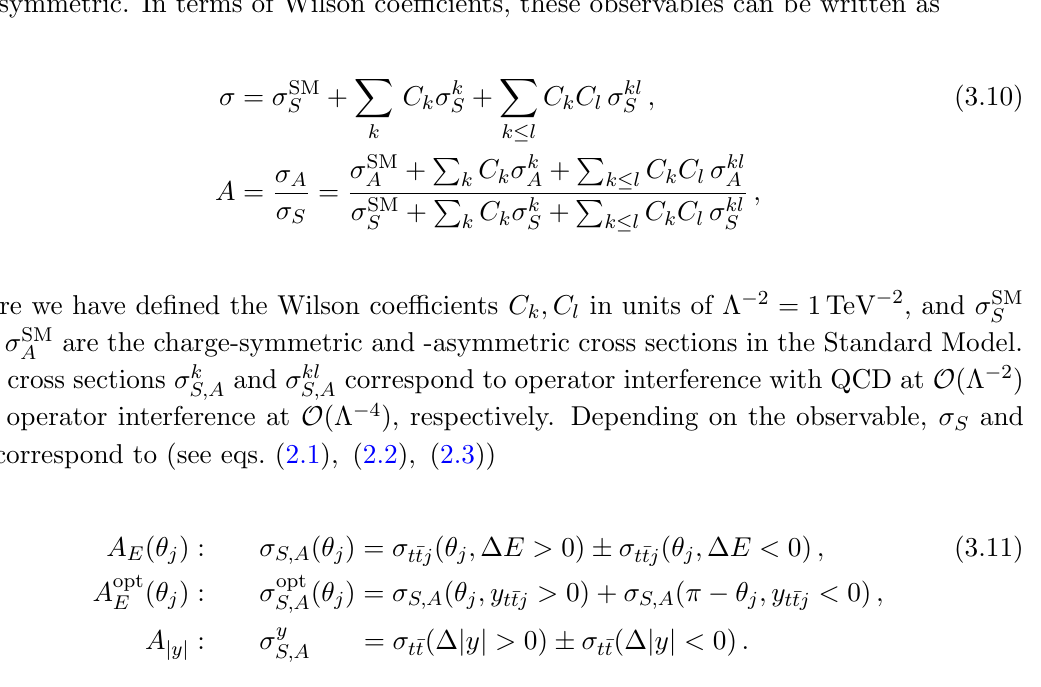
symmetric under top-antitop interchange, while observables of the charge asymmetry are antisymmetric. In terms of Wilson coe(cid:14)cients, these observables can be written